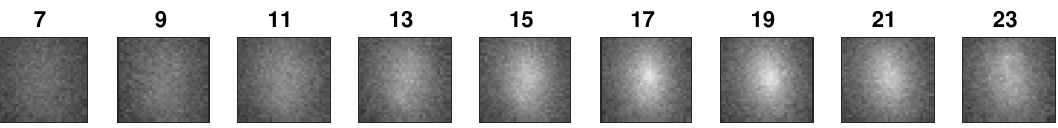
Figure 2. Exemplary slices from synthetic volume (there are three overlapping additive